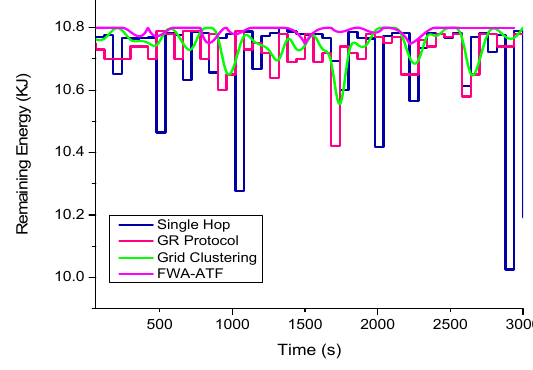
Figure 2. Remaining energy of nodes.